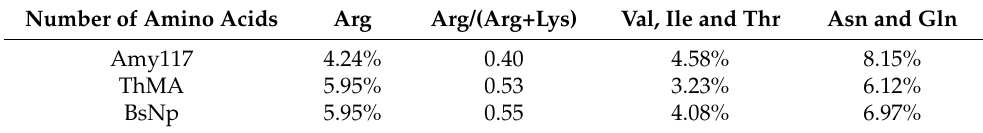
Table 3. The amino acid content of Amy117 and the other two proteins (ThMA and BsNp). Number of Amino Acids Arg Arg/(Arg+Lys) Val, Ile and Thr Asn and Gln